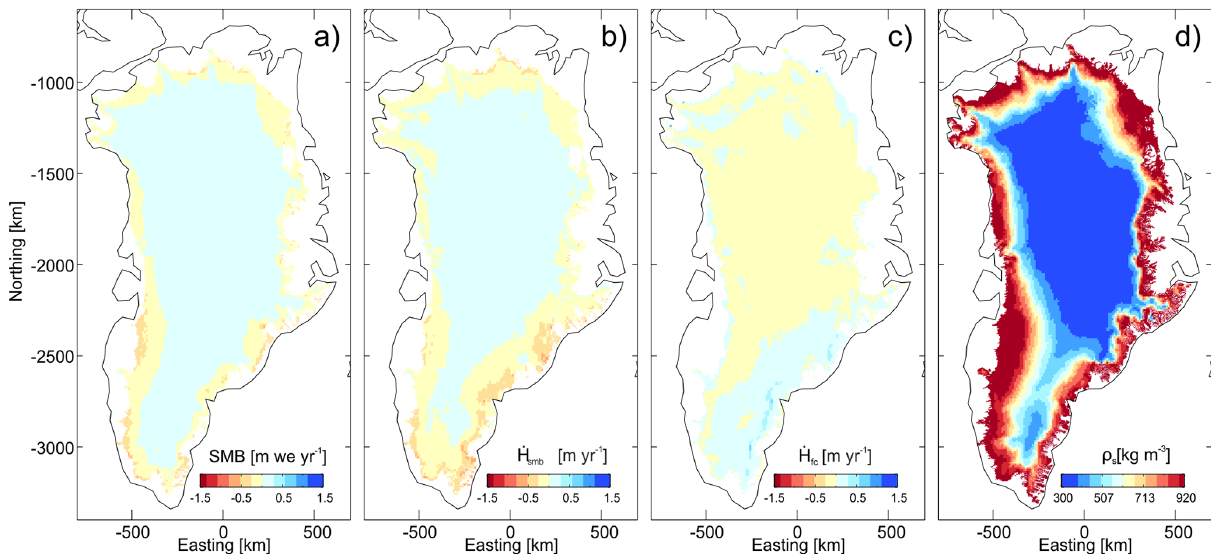
Figure 5. As in Figure 4 but for